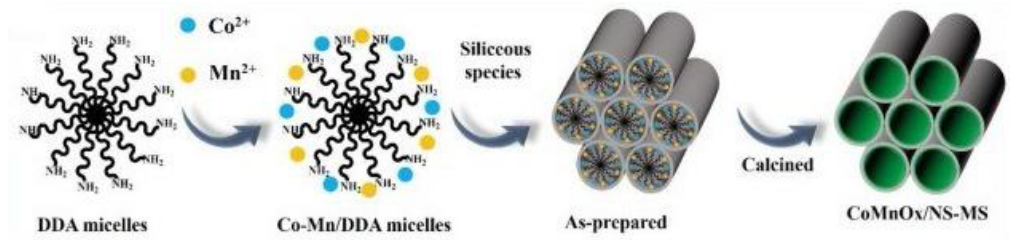
Figure 7. Schematic illustration for the synthesis of Co-Mn bimetallic oxides decorated nanospherical HMS.